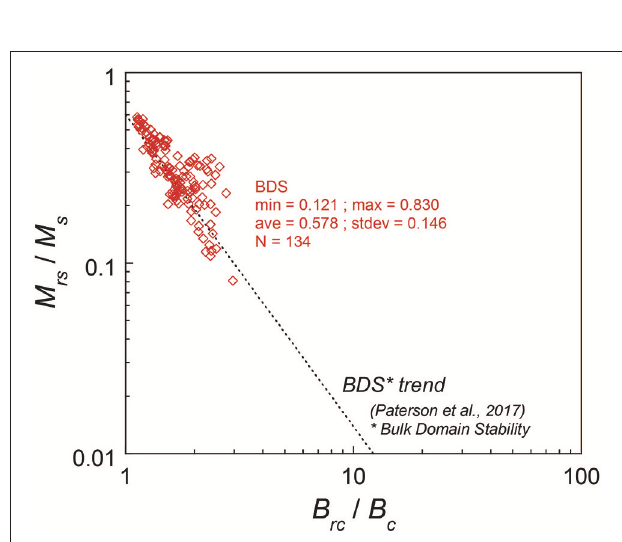
FIGURE 3 | Relation between the hysteresis ratios of B rc /B c and M rs /M s for the chip samples. The dotted line indicates the BDS trend by Paterson et al. (2017)